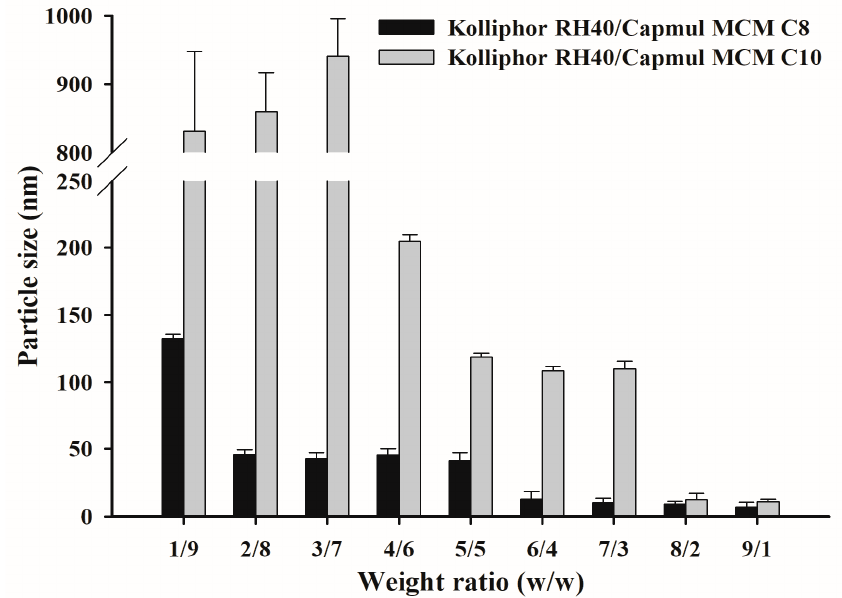
Figure 2. The solubility of PZH in various surfactants, oils, and solubilizers.